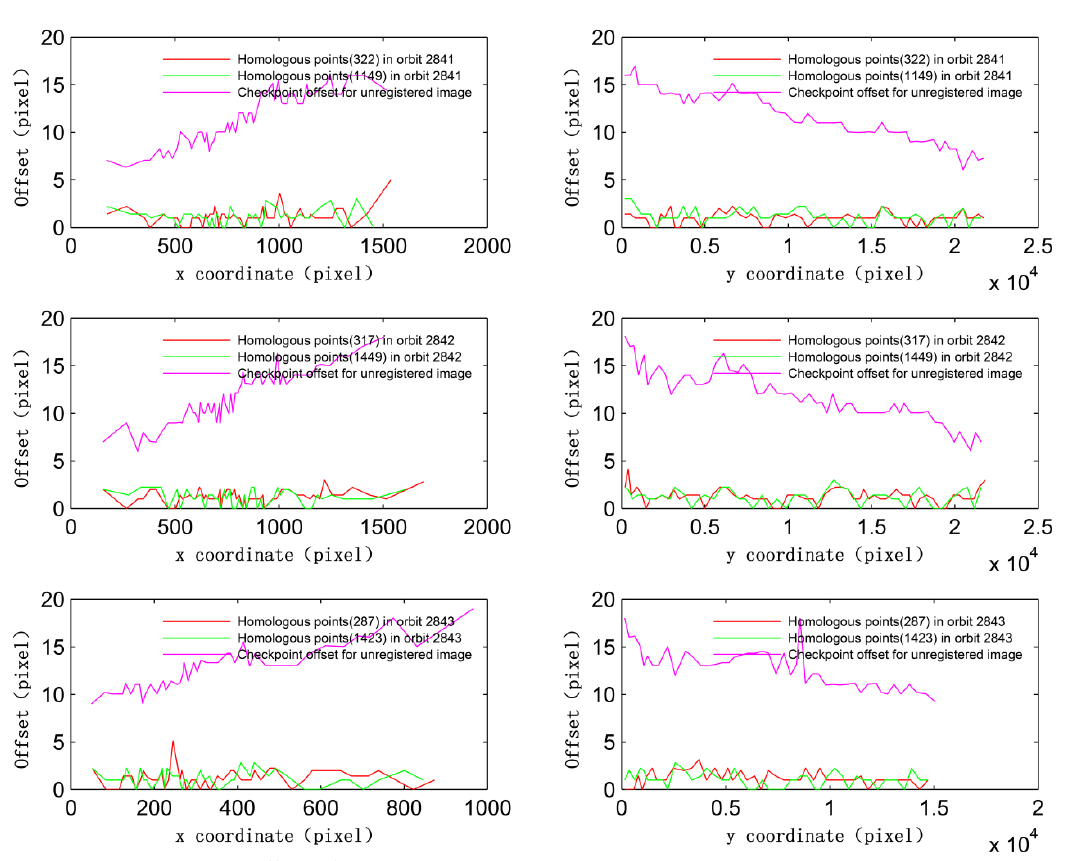
Figure 5.The offsets of three orbit IIM images are displayed in x direction and y direction Fig.5 shows the checking points’ offsets from each orbit of the IIM image displayed in the x-direction and y-direction of the image. The pink line corresponds to the checking points’ offsets between the origin IIM images and LRO image, the green line corresponds to the checking points’ offsets by method proposed in this paper, while the red line corresponds to the checking points’ offsets of manually selected homologous points. It can be seen the method proposed in this paper can realize the accurate registration of IIM images .Compared the checking